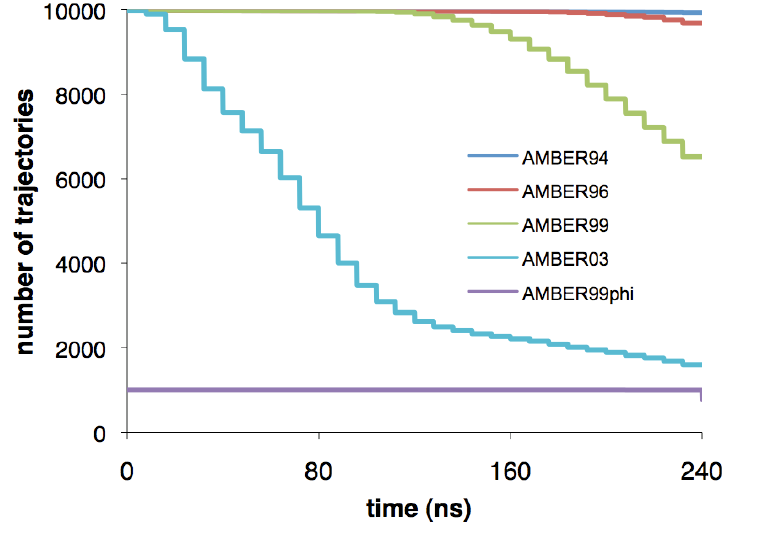
Figure 2. The distribution of trajectories achieving a given trajectory length, shown for the forcefields tested in this